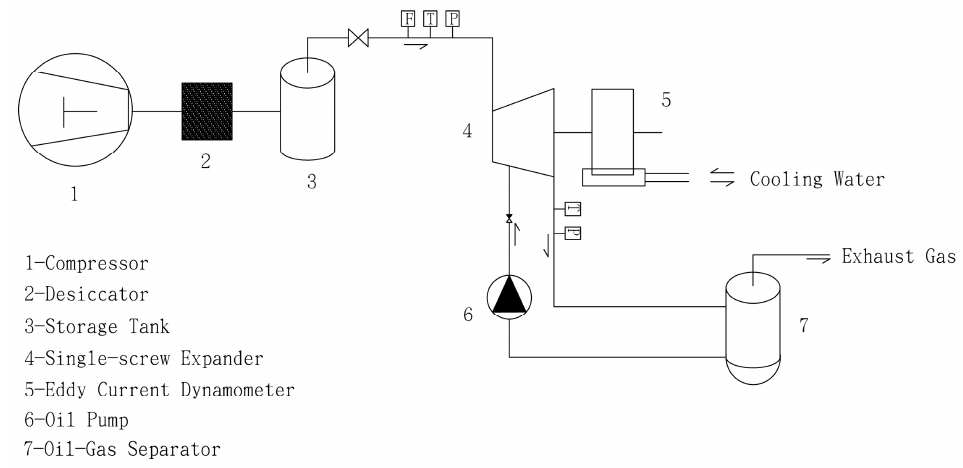
Figure 4. Schematic diagram of the experimental system.